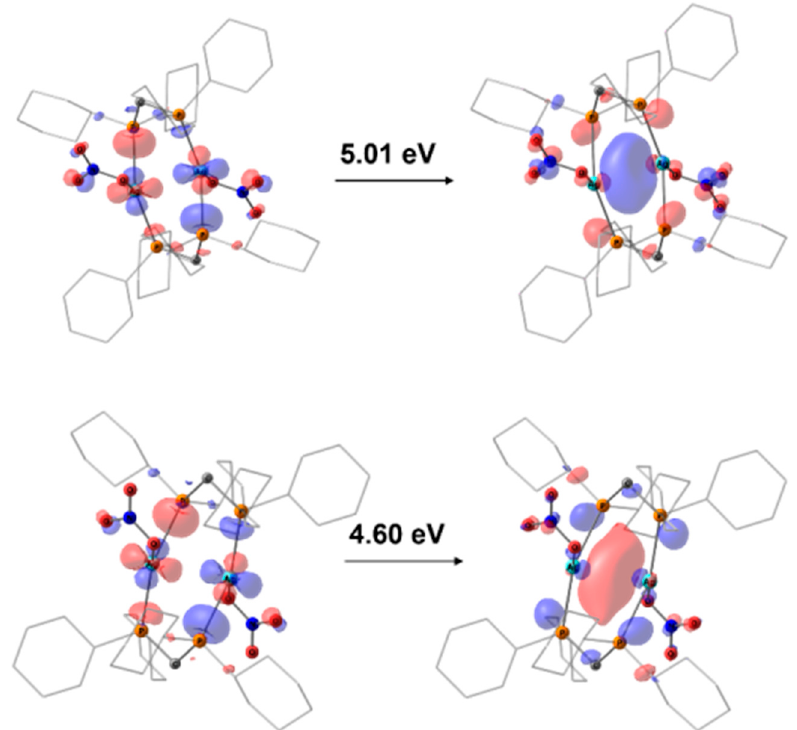
Figure 5. Highest occupied natural transition orbital (HONTO) and lowest unoccupied natural transition orbital (LUNTO) for the S 0 → S 2 ( top ) and S 0 → T 3 ( bottom ) transition in complex 1 as the isosurface at 0.05 a.u.